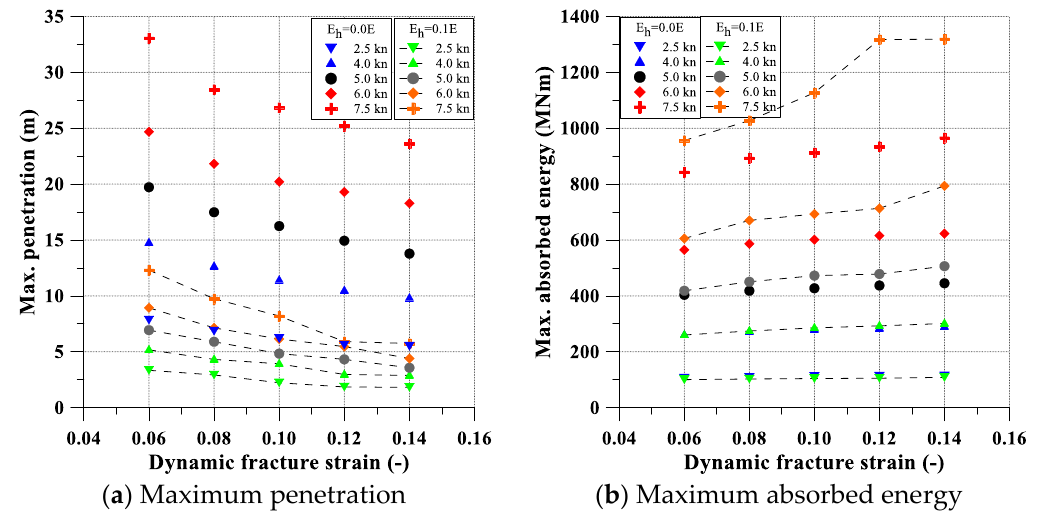
Figure 9. Comparison of the maximum structural responses. Table 4. Summary of effects of the case study on the maximum penetration ( Pen. ) and absorbed energy ( Ab. E. ).